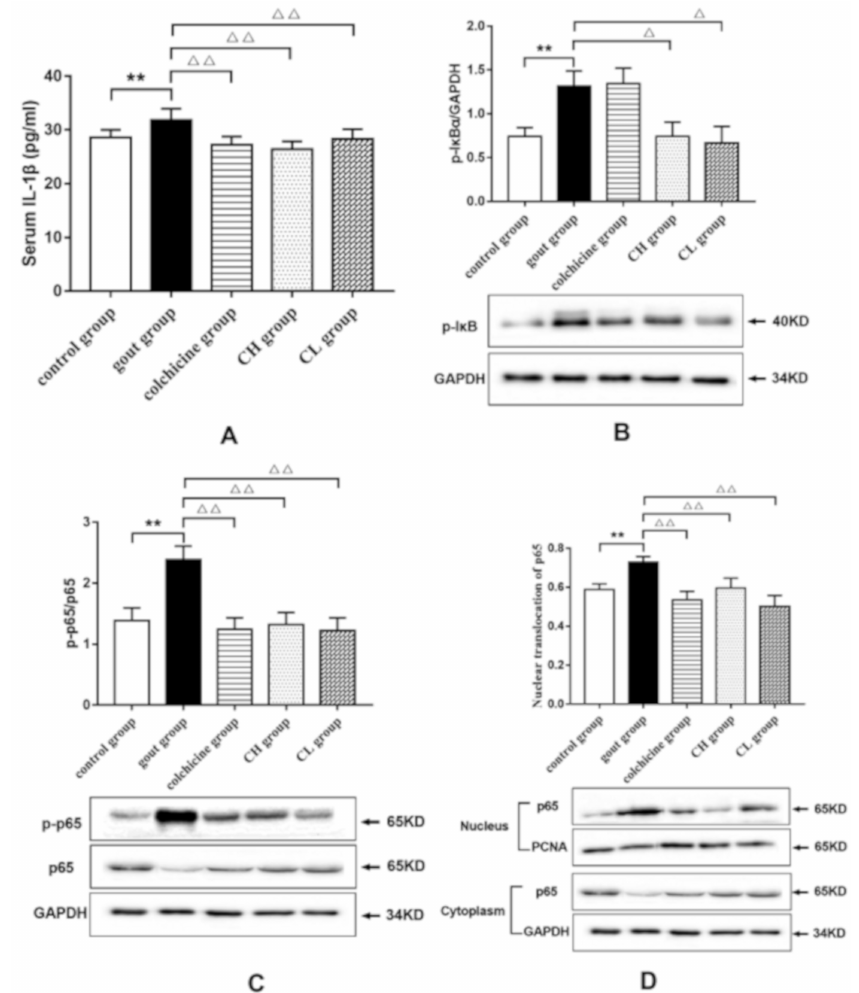
Figure 3. E ff ect of chicory extract on serum IL-1 β and expressions of key targets of the NF- κ B signaling pathway in ankle synovial tissues of MSU-induced gout rats: ( A ) Levels of serum IL-1 β , ( B ) protein expression levels of p-I κ B, ( C ) protein expression levels of p-p65, and ( D ) nuclear translocation of p65. Data are expressed as mean ± SD for six rats in each group. ** p < 0.01 vs. control group. (cid:52) p < 0.05, (cid:52)(cid:52) p < 0.01 vs. gout